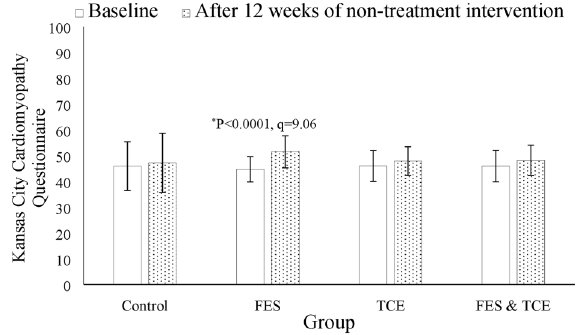
Figure 3. Effects of non-pharmacological interventions on endothelium-dependent brachial artery fl ow-mediated dilatation. RM-MANOVA followed by Tukey ’ s post hoc test was used for statistical analysis. Data are reported as means ± SD at baseline and after 12 weeks of intervention. *P o 0.05 compared to the control group. FES: functional electrical stimulation of lower limb muscles; TCE: Tai Chi exercise.